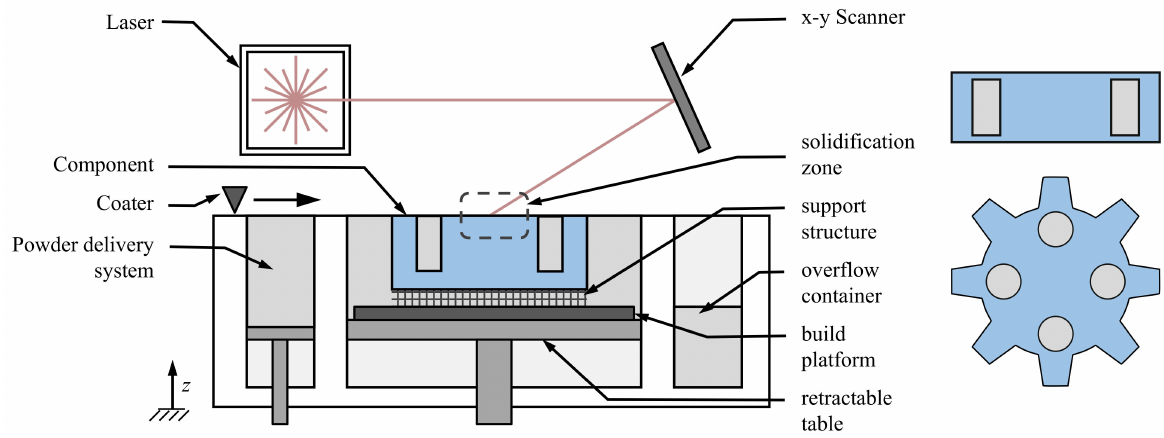
Figure 1. Laser powder bed fusion of a particle damped gear, reprinted with permission from ref. [7]. Copyright Elsevier.